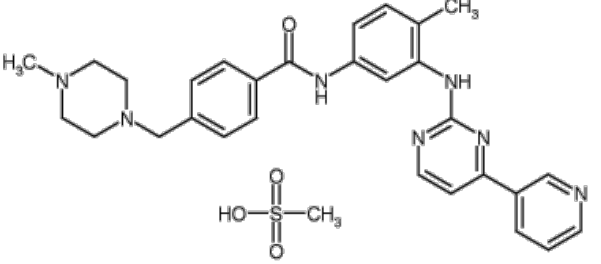
Figure 1. Chemical structure of imatinib mesylate prepared by means of ChemDraw Professional software (PerkinElmer, Waltham, MA, USA).